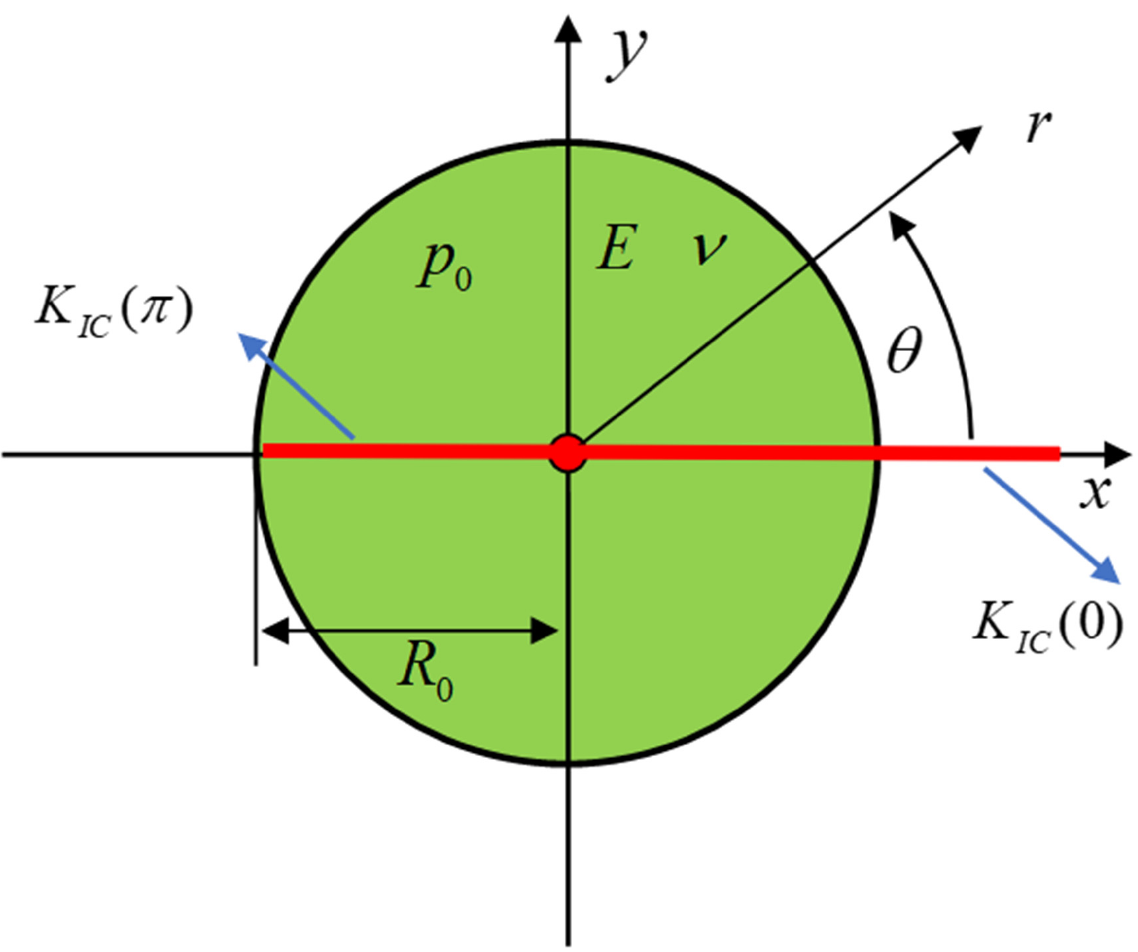
Figure 2. The initial conditions of the model and rock mechanical properties.